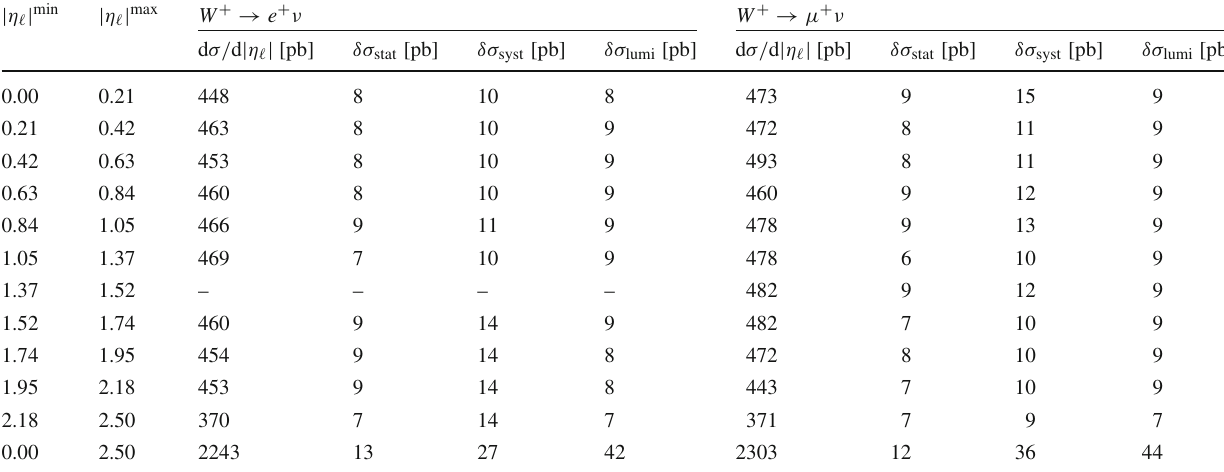
Table 3 Measured fiducial W + → (cid:5) + ν differential and integrated cross sections for electron and muon channels | η (cid:5) |